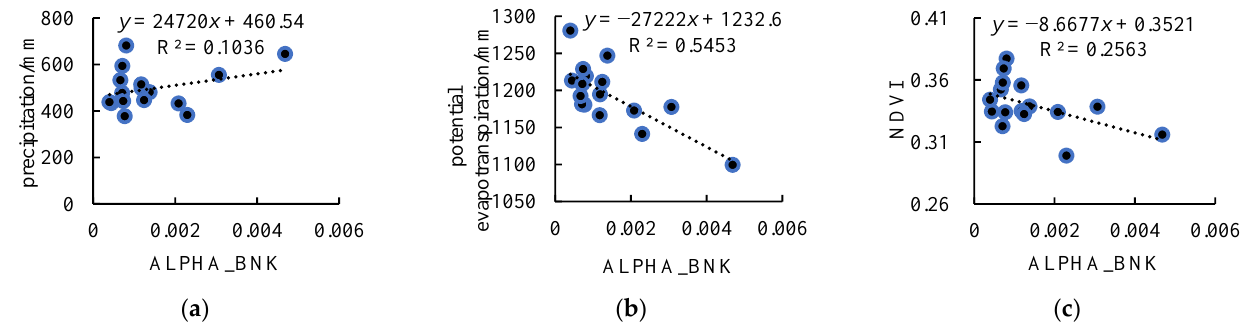
Figure 14. Correlation of ALPHA_BNK to watershed precipitation, potential evapotranspiration, NDVI. ( a ) Precipitation, ( b ) potential evapotranspiration, ( c ) NDVI.